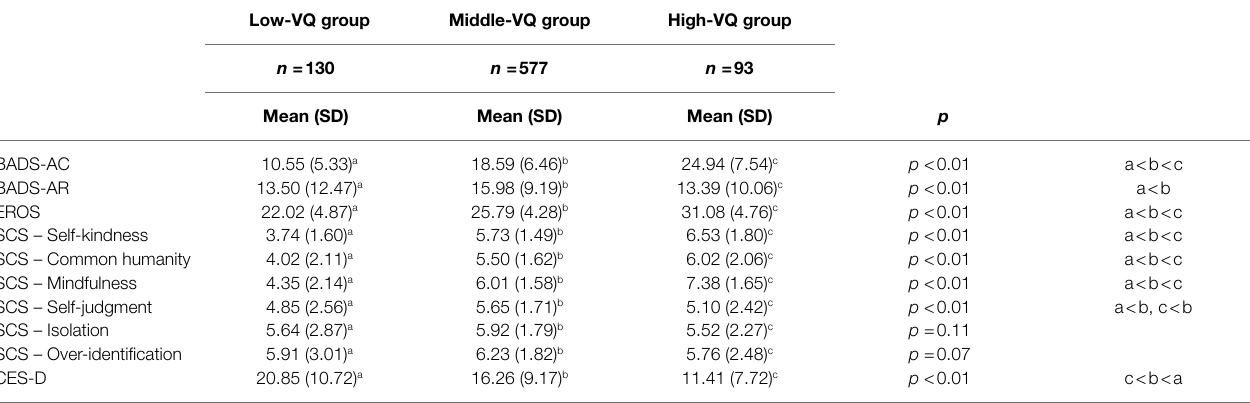
TABLE 2 | Results of multiple comparisons. Low-VQ group Middle-VQ